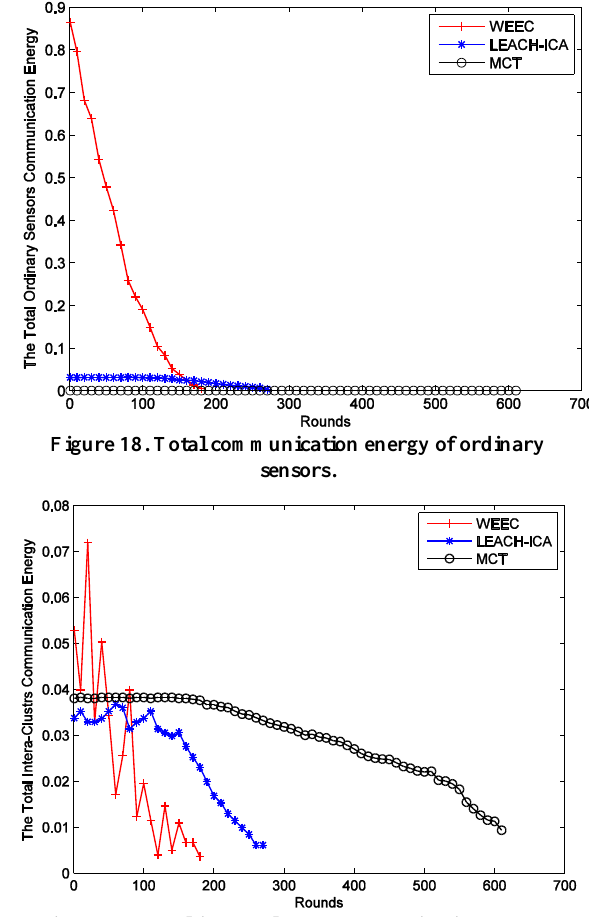
Figure 19. Total intera-cluster communication